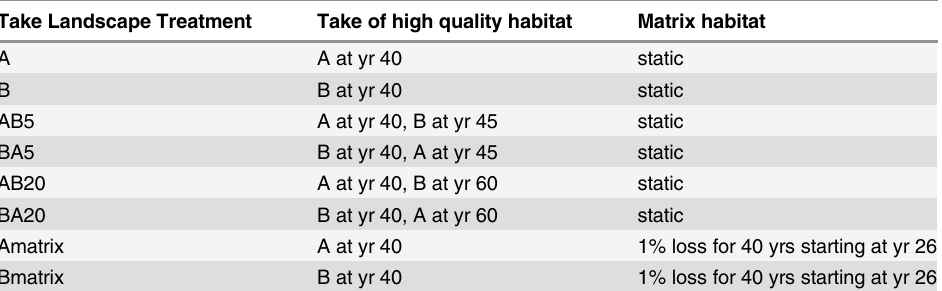
Table 1. Description of how habitat loss was applied across landscape treatments after the addition of the bank in year 25. Two areas were considered as takes, “ A ” and “ B ” (Fig 1). Take Landscape